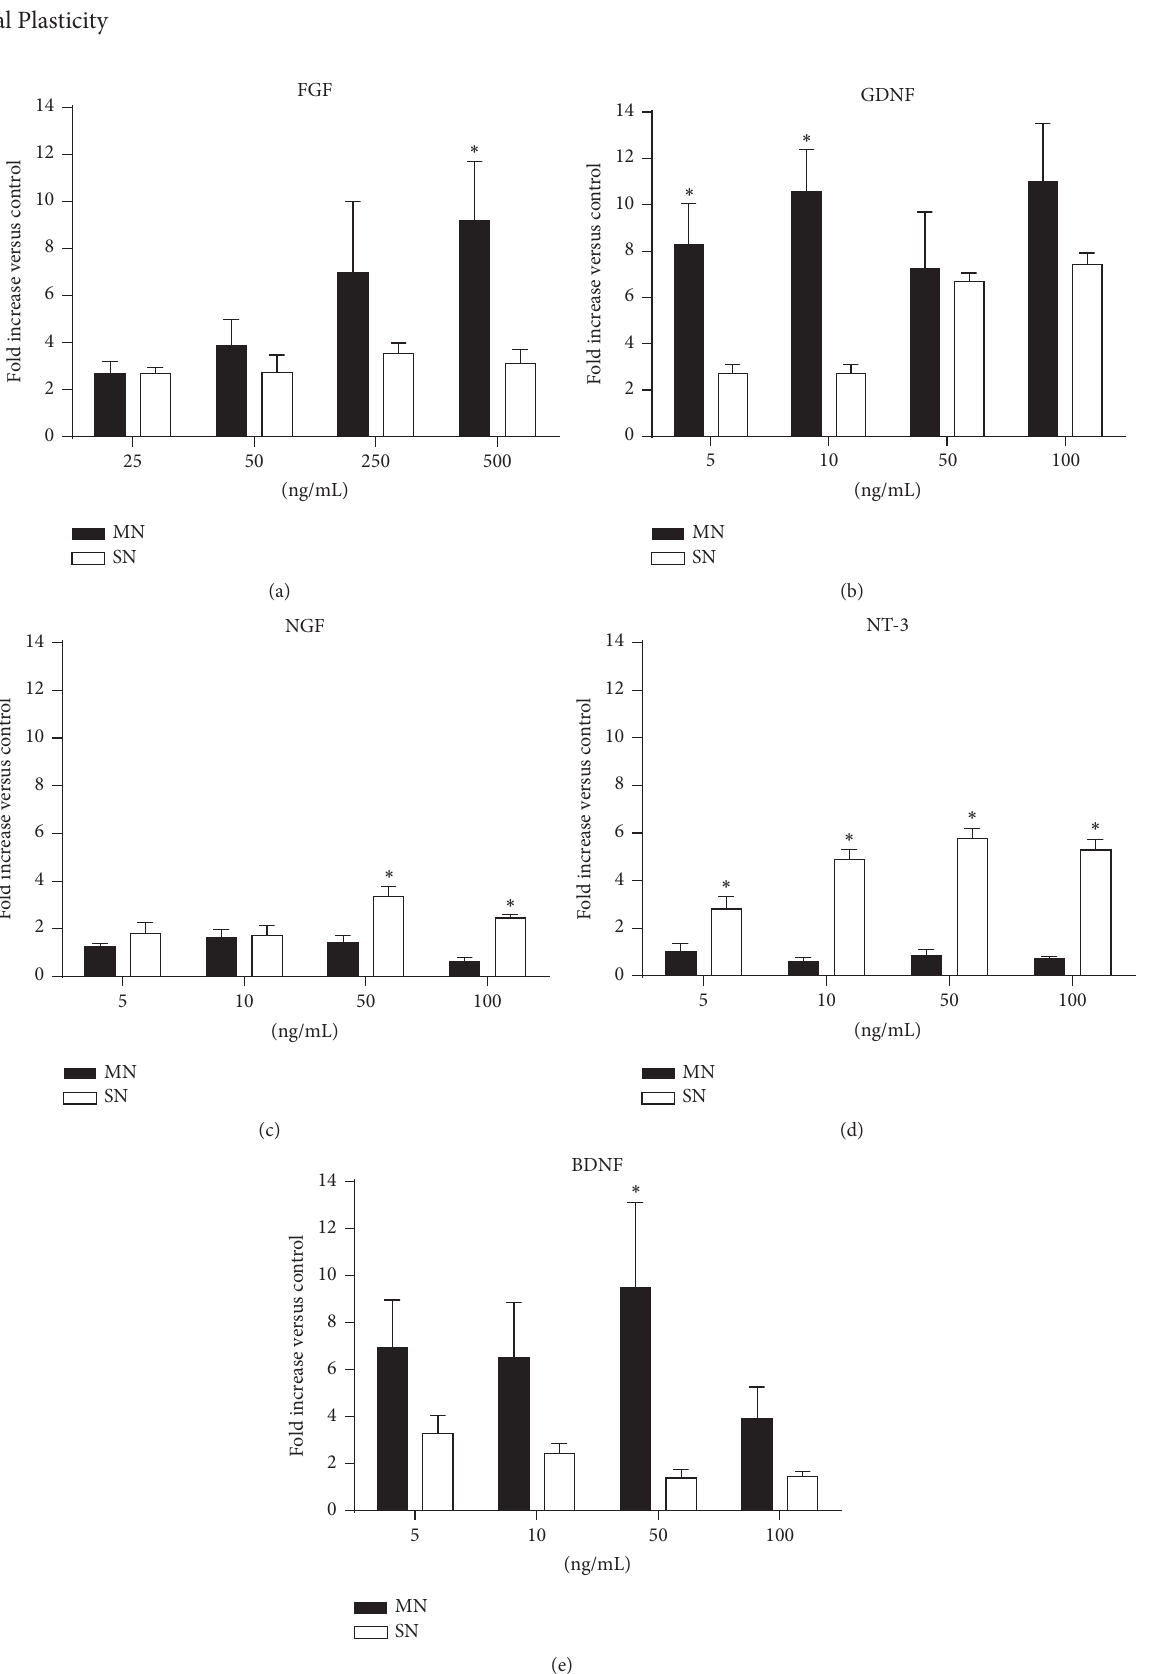
Figure 4: Histogram of the fold increase of the AUC for motor and sensory neurite outgrowth induced by FGF (a), GDNF (b), NGF (c), NT-3 (d), and BDNF (e) at the concentrations tested compared to the control collagen matrix. Data expressed as mean ± SEM. ∗ 𝑝 < 0.05